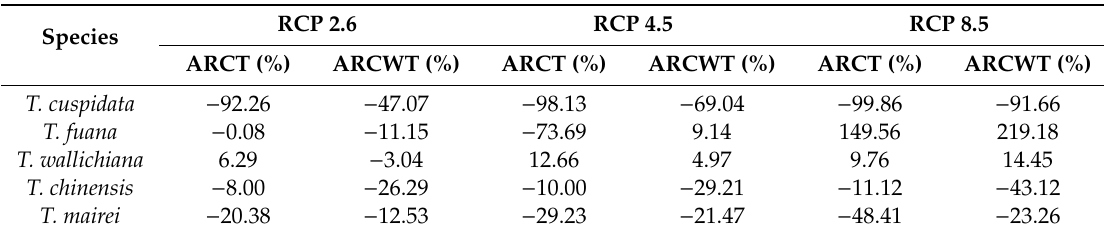
Table 2. Projected range changes of each species under future environmental change scenarios